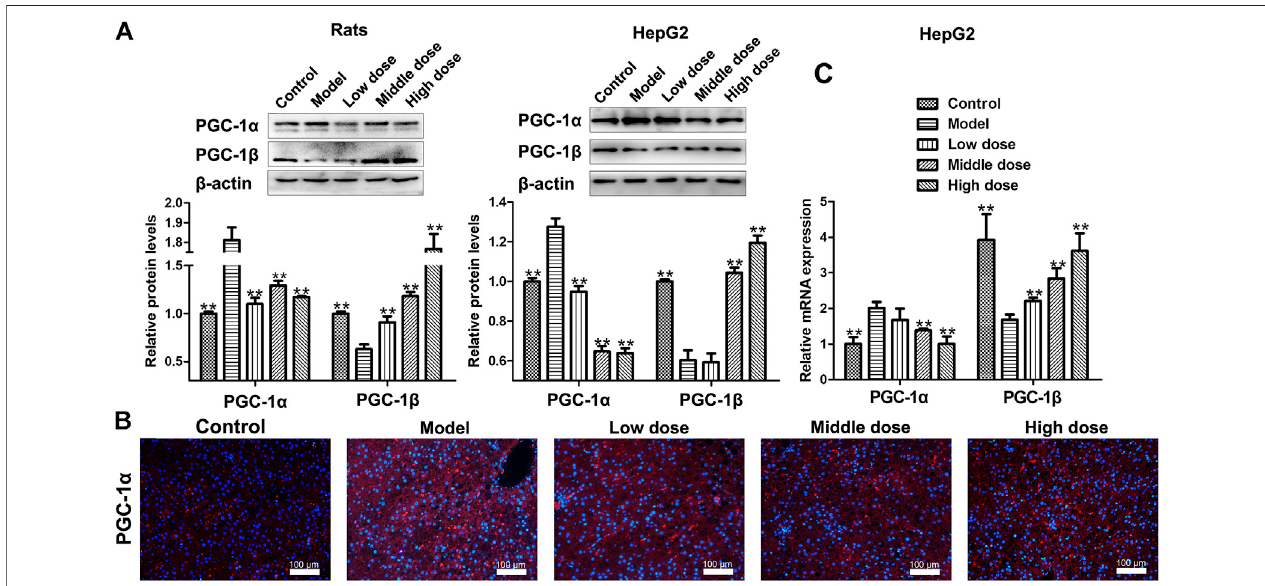
FIGURE 5 | Effect of HSAV on the expression of PGC-1 α and PGC-1 β . (A) The expression levels of PGC-1 α and PGC-1 β detected by Western blot. (B) The expression of PGC-1 α in the liver of rats analyzed by immuno fl uorescence. (C) The mRNA levels of PGC-1 α and PGC-1 β in HepG2 cells analyzed by Real-time PCR. Data are presented as the mean ± SD (n (cid:2) 3). * p < 0.05 and ** p < 0.01 compared with model group.